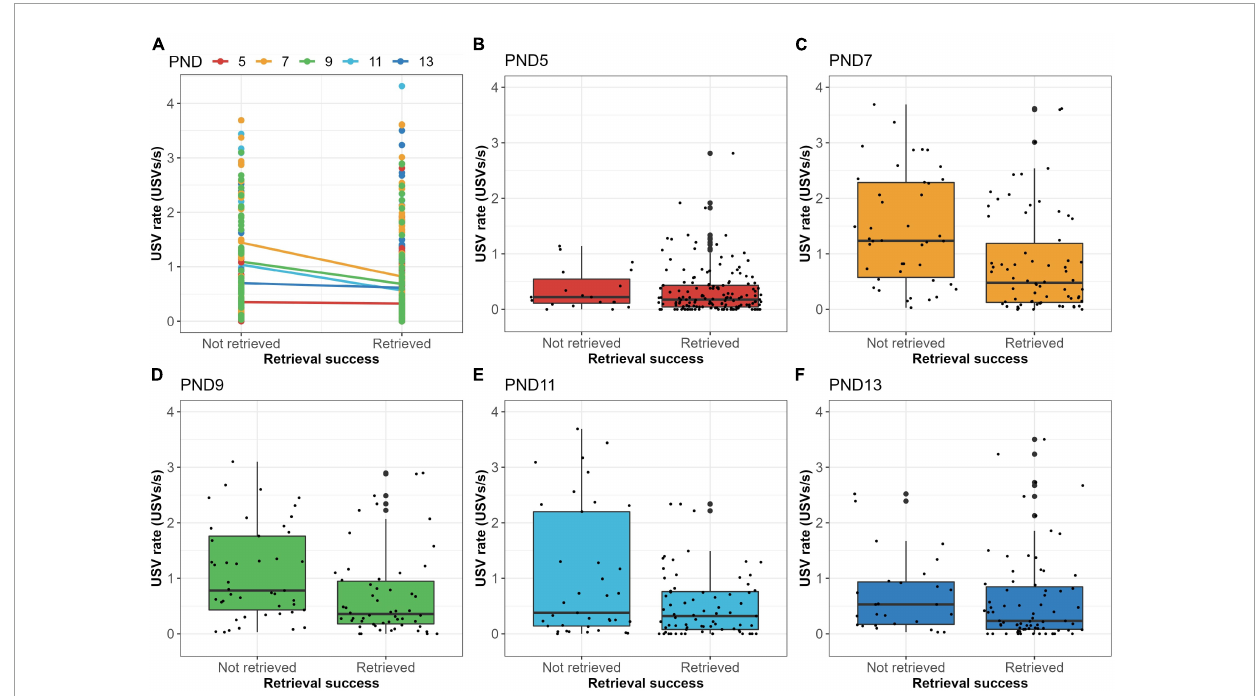
FIGURE5 USV rate vs. retrieval success for each test day separately. (A) Plot with linear regression of USV rate vs. retrieval success scored as a binary variable for each test day separately. For all test days (PND5-13), USV rate was higher in non-retrieved pups than in retrieved pups, although regression estimates were close to 0 (horizontal regression line) for PND5 and PND13. (B) Boxplot showing the USV rate (USVs per second) for pups which are either retrieved or not retrieved on PND5. (C) Boxplot showing the USV rate (USVs per second) for pups which are either retrieved or not retrieved on PND7. (D) Boxplot showing the USV rate (USVs per second) for pups which are either retrieved or not retrieved on PND9. (E) Boxplot showing the USV rate (USVs per second) for pups which are either retrieved or not retrieved on PND11. (F) Boxplot showing the USV rate (USVs per second) for pups which are either retrieved or not retrieved on